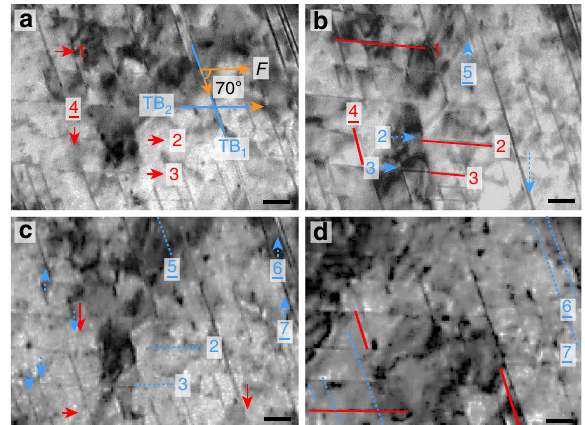
Fig. 1 Coactivation of twinning and detwinning in the intersected NTs. a – d are bright- fi eld TEM images of the intersected NTs, showing the deformation evolution during in situ tensile test. TB 1 exhibits a 70° angle to F and TB 2 is parallel to F , as given in a . The red solid lines and arrows, including Lines 1 – 3 and Arrows 1 – 3 in the tensile direction and Line 4 and Arrow 4 in the 70° shear direction, indicate the twinning positions. The blue dotted lines and arrows, including Lines 2, 3 and Arrows 2, 3 in the tensile direction and Lines 5 – 7 and Arrows 5 – 7 in the 70° shear direction, illustrate the detwinning positions. The standard deviation of λ is 0.5 nm. F is the external tensile load. The time frames from a – d are 0, 12, 27 and 52 s, respectively. All scale bars are 20